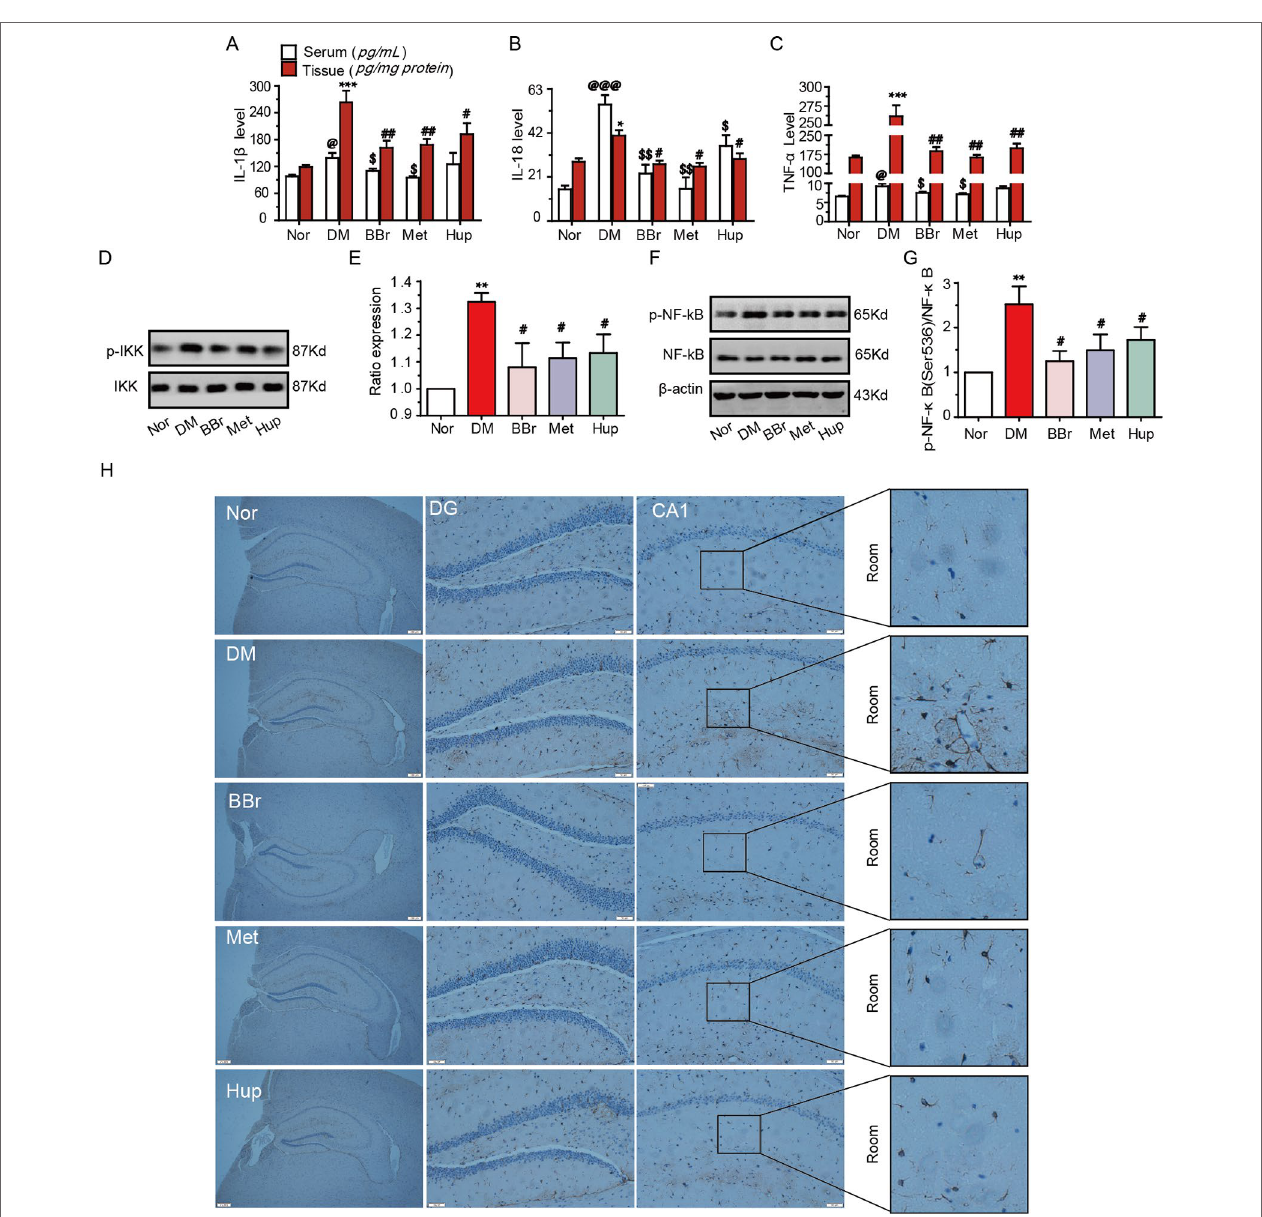
FIGURE 3 | Berberine inhibited inflammatory response in diabetic rats. The IL-1 β (A) , IL-18 (B) and TNF-a (C) levels were measured using ELISA kits, n = 8–12. Inflammatory pathway related molecular p-IKK/IKK (D , E) and p-NF-kB/NF-Kb (F , G) levels were detected by Western-blot, n = 3. The GFAP expression was appraised by IHC (H) , n = 3. * P < 0.05 vs. Nor; ** P < 0.01 vs. Nor; *** P < 0.001 vs. Nor; @ P < 0.05 vs. Nor; @@@ P < 0.001vs. Nor; # P < 0.05 vs. DM; ## P < 0.01 vs. DM; $ P < 0.05 vs. DM; $$ P < 0.01 vs.